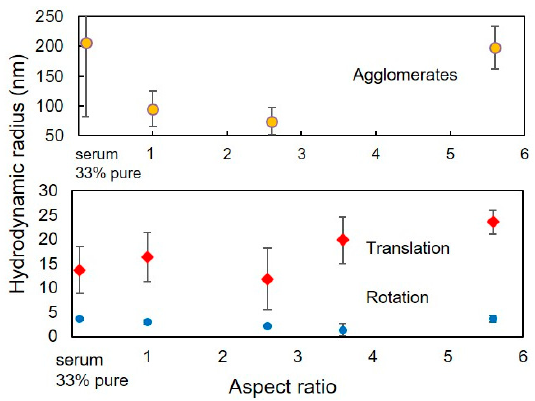
Figure 4. Hydrodynamic radii of filtered mouse serum upon interaction of mouse serum (33%) with gold nanoparticles analyzed using the CORENN algorithm. The hydrodynamic radii of the pure filtered 33% mouse-serum are shown for the convenience of comparison in the same graph.